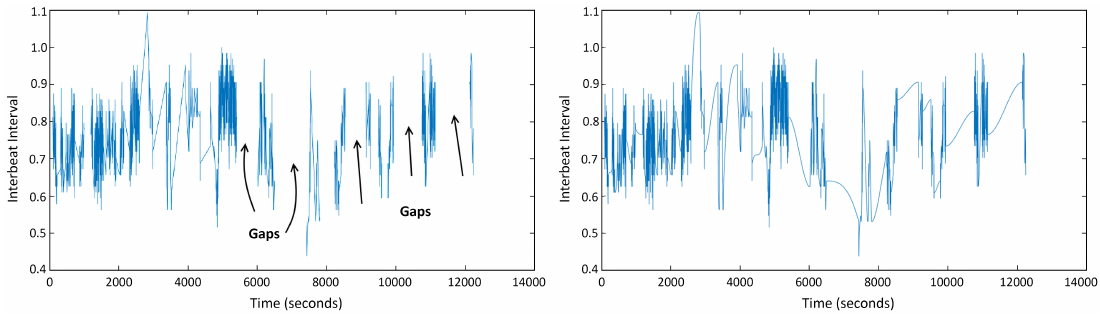
Figure 6. Gaps due to movement and loosely worn wristband from PPG (Photoplethysmography) data ( Left ) are filled with cubic interpolation function ( Right